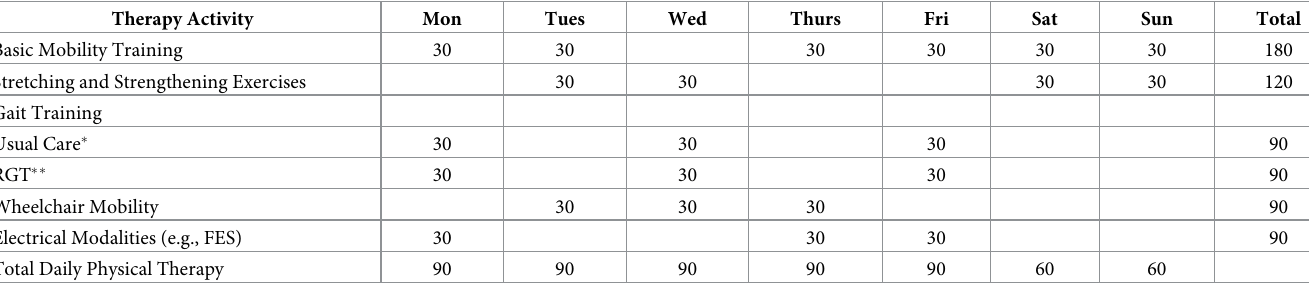
Wheelchair Mobility Electrical Modalities (e.g.,